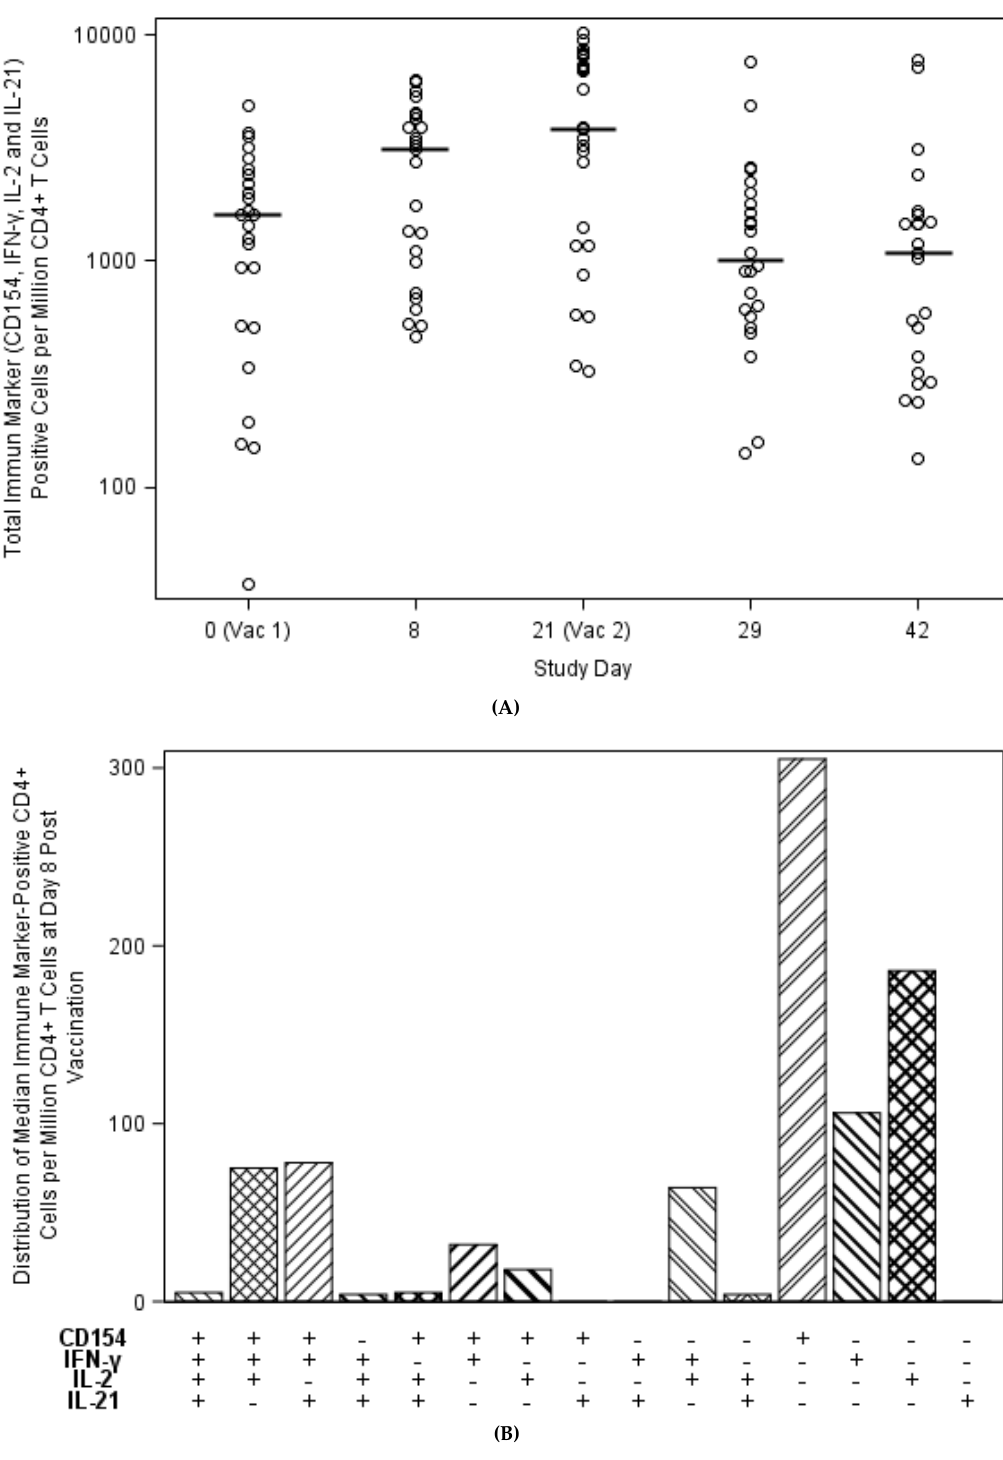
Figure 3. CD4+ T cell responses induced by H3N2v vaccination. ( A ) Temporal H3N2v CD4+ T cells Figure 3. CD4 + T cell responses induced by H3N2v vaccination. ( A ) Temporal H3N2v CD4 + T cells among vaccinees as determined by 4 immune marker secretion (CD154, IFN-γ, IL-2 and IL-21), and among vaccinees as determined by 4 immune marker secretion (CD154, IFN- γ , IL-2 and IL-21), and ( B ) ( B ) Immune marker profile of CD4+ T cells at Day 8. Immune marker profile of CD4 + T cells at Day